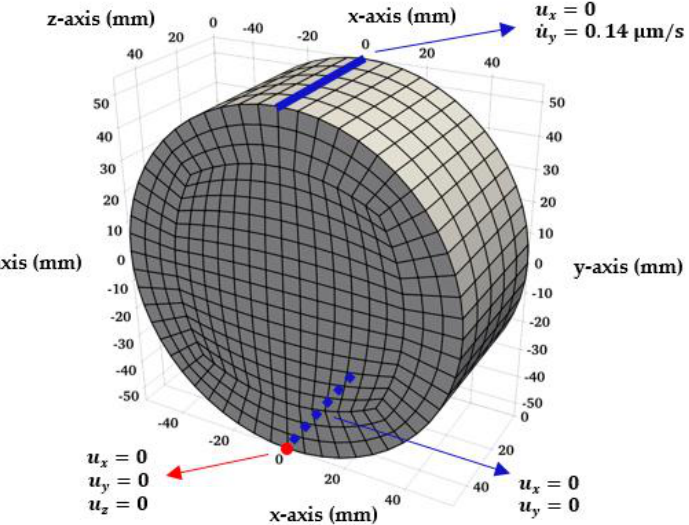
Figure 1. Geometry of the problem and the finite element discretization.